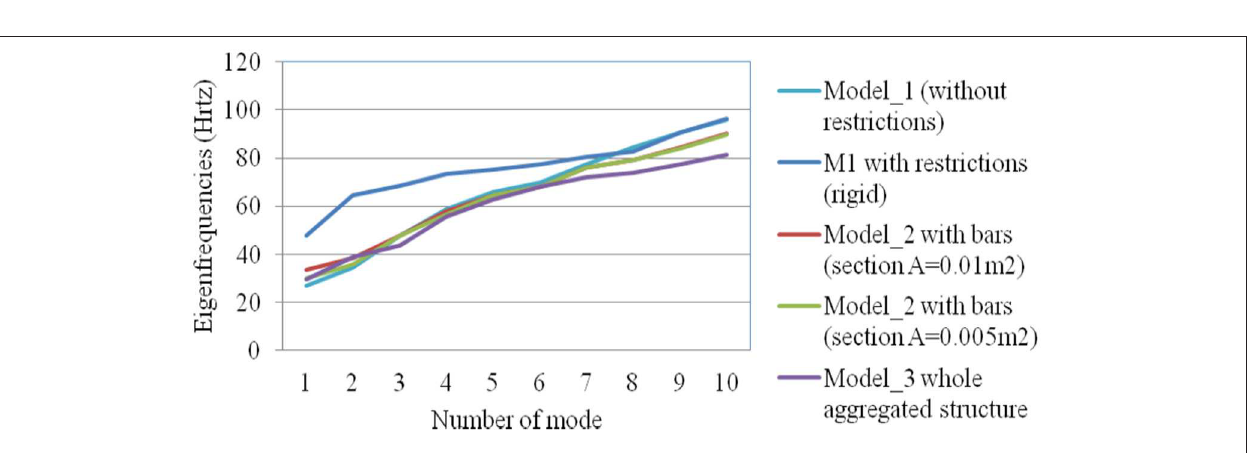
FIGURE 3 | Natural frequencies of the finite element (FE)